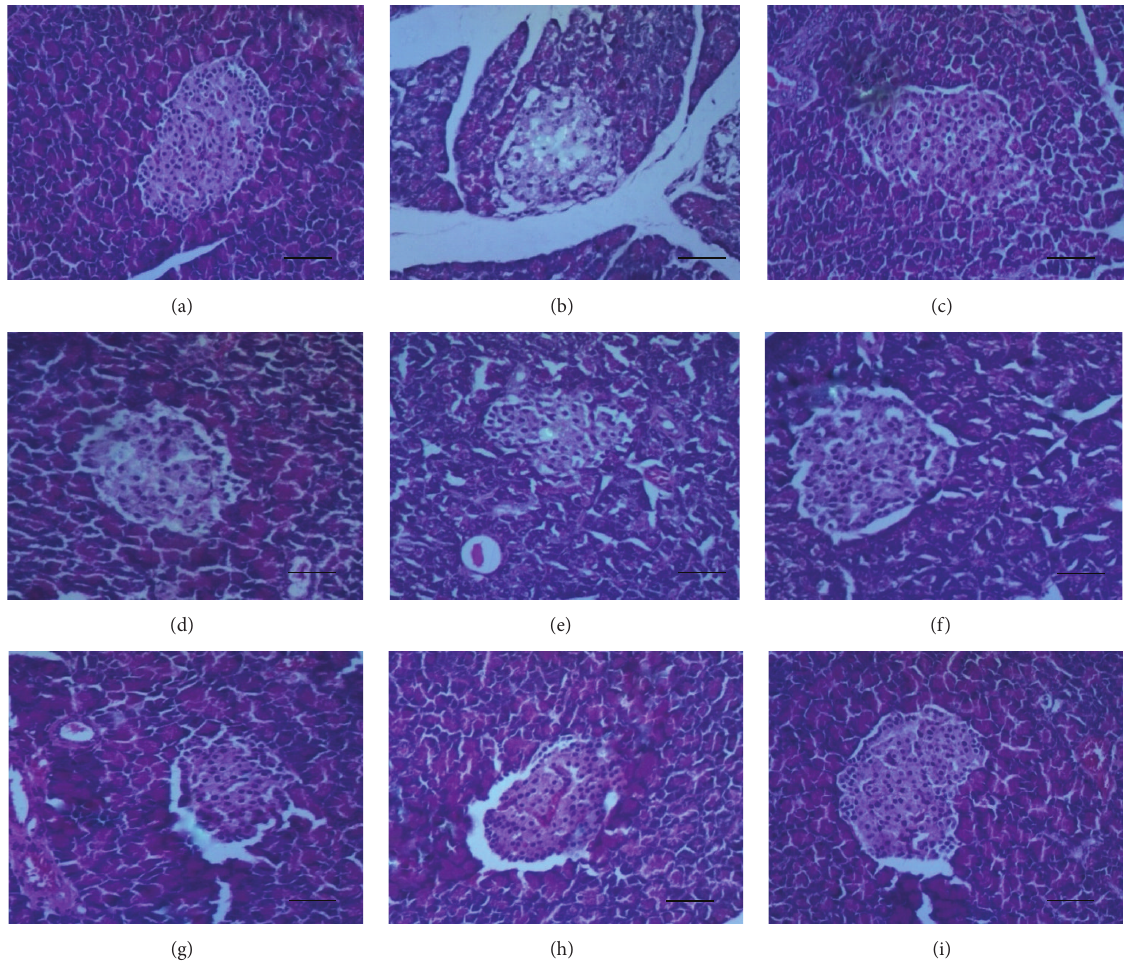
Figure 4: Photomicrograph of histological sections of pancreas. (a) Normal control: section shows normal histology of pancreas with high cellularity of the islet of Langerhans. (b) Negative control: islets show highly reduced cellularity of the endocrine islets with inter- and intracytoplasmic vacuolations. (c) Positive control: it has normal arrangement of islet cells and the cellularity is likened to that of the normal control. (d) 10mg/kg YL: reduction of cells in the middle portion of the islets of Langerhans. Sign of little regeneration. (e) 10mg/kg OL: it also shows atrophy of islet with little regeneration of resident cells. (f) 30 mg/kg YL: islet has increased number of cells as compared to the normal control but being less compact. (g) 30 mg/kg OL: it also shows sign of regeneration but cellularity is less pronounced as compared to the 30 mg/kg YL. (h) 300 mg/kg YL: it shows sign of total regeneration of cells of the islet. (i) 300 mg/kg OL: it displays sign of total regeneration of the islets of Langerhans (H&E stain 100x). Bar = 20 𝜇